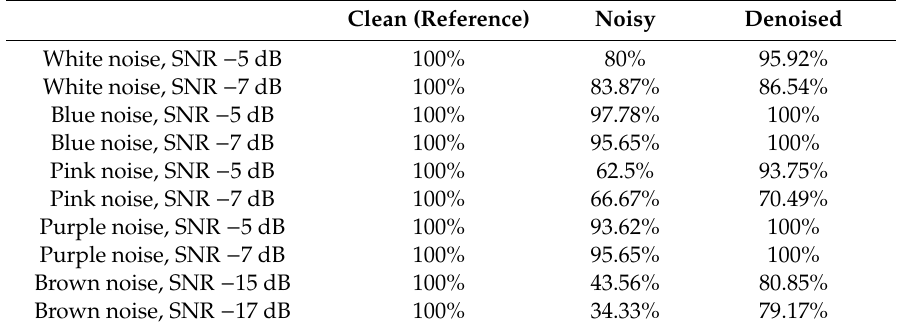
Table 1. The percent of correctly detected peaks in clean (reference), noisy, and denoised sequences. Clean